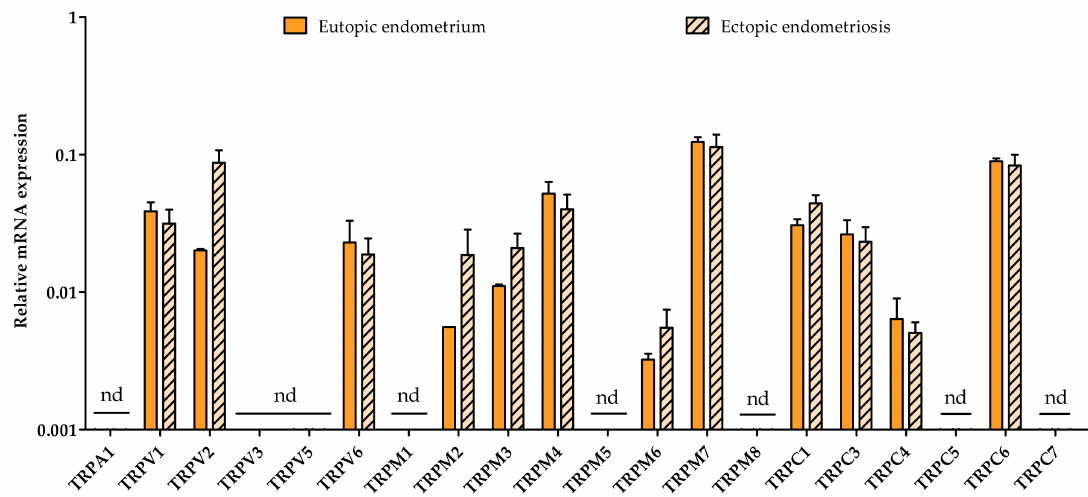
Figure 5. TRP channel expression in eutopic versus ectopic endometrial biopsies . RT-qPCR of TRP channels paired eutopic and ectopic tissue from grade II endometriosis patients during the follicular phase ( n = 3) [37]. Messenger RNA levels were quantified to the geometric mean of housekeeping genes ACTB, GAPDH, HPRT, PGK-1, and TBP. TRPM1, TRPM5, TRPM8, TRPC5, and TRPC7 were below the detection limit. nd: not detectable. Data are presented as mean + SEM.